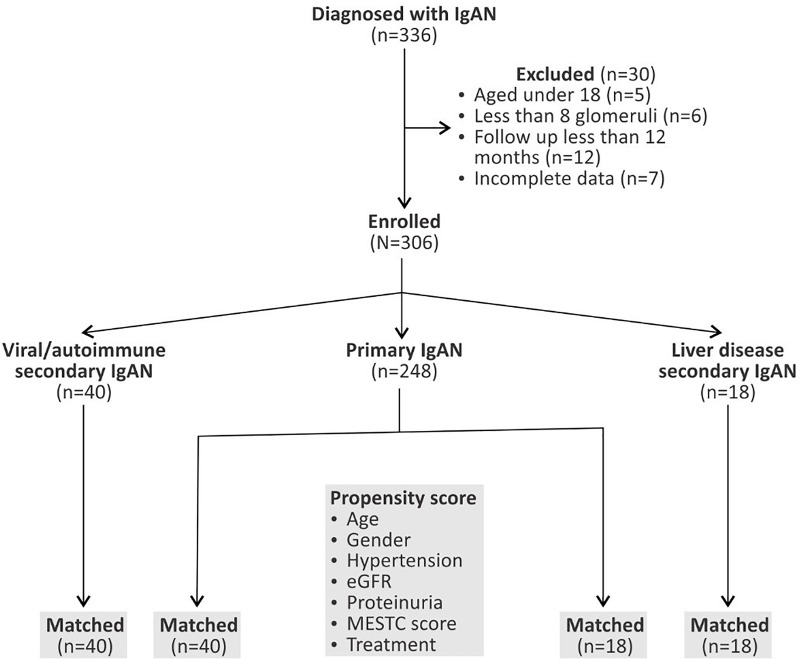
Patients’ flow chart and the formation of samples used for matching.